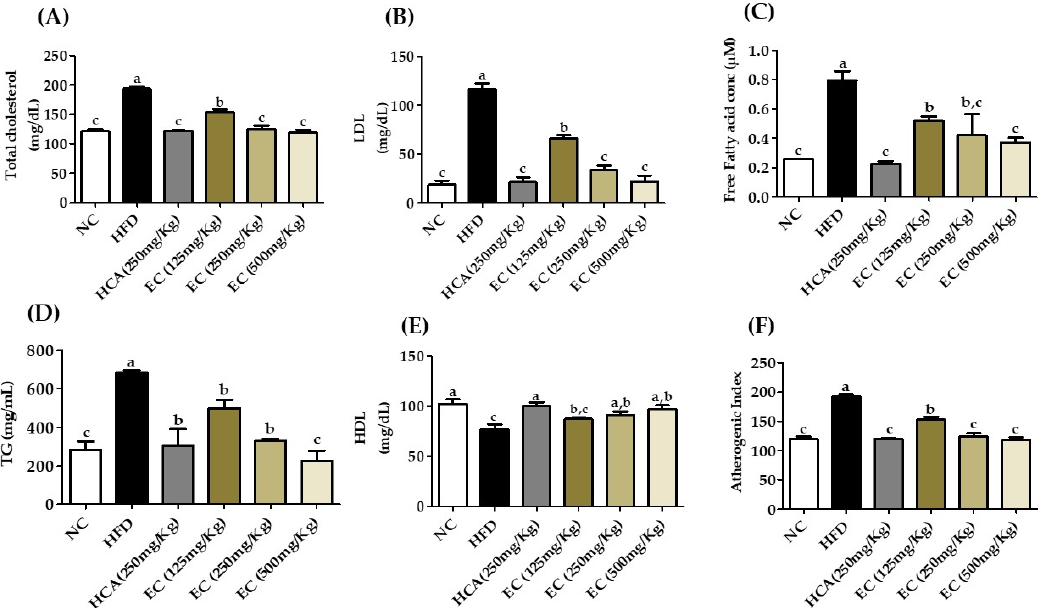
Figure 8. The effects on the lipid profile of rats fed a normal diet and a high-fat diet with or without treatment of different doses of ECE (125, 250, and 500 mg/kg b.w) for 8 weeks. ( A ) Total cholesterol, ( B ) LDL ((low-density lipoproteins), ( C ) free fatty acid, ( D ) triglyceride (TG), ( E ) HDL (high-density lipoproteins), and ( F ) atherogenic index (AI). Data are presented as means ± SEM ( n = 8 for each group). Values with different letters present significant differences ( p < 0.05).